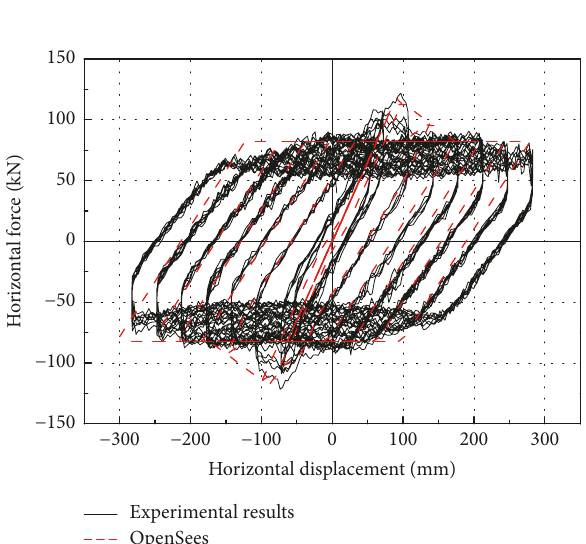
detailed dimensions and reinforcement layout of the shear keys are shown in Figure 16. There were 18 inverted U-shaped HRB335 rebars with diameters of 16 mm along the length direction, which extended to the pier cap of 0.56 m. Stirrups with diameters of 10 mm and a pitch of 100 mm were used for the shear keys. The initial gap between the shear keys and the girder was 0.05 m. All of the calculation values of the used material, along with the cross section, were consulted